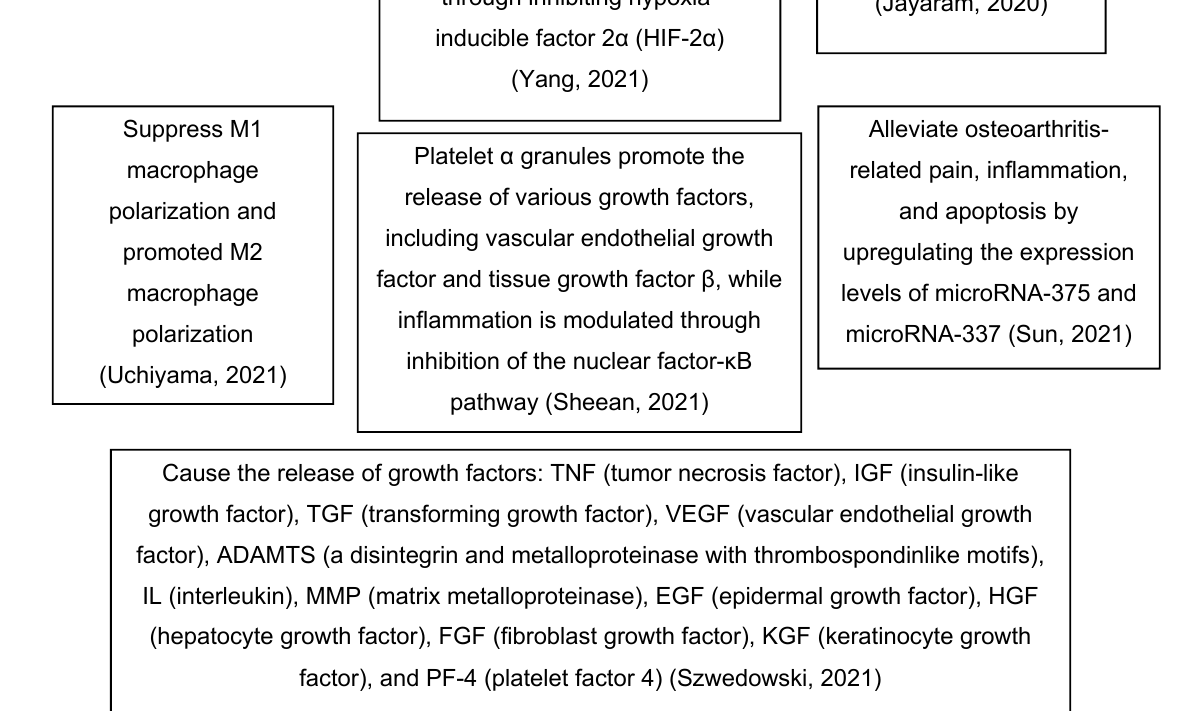
factor), and PF-4 (platelet factor 4) (Szwedowski, 2021)